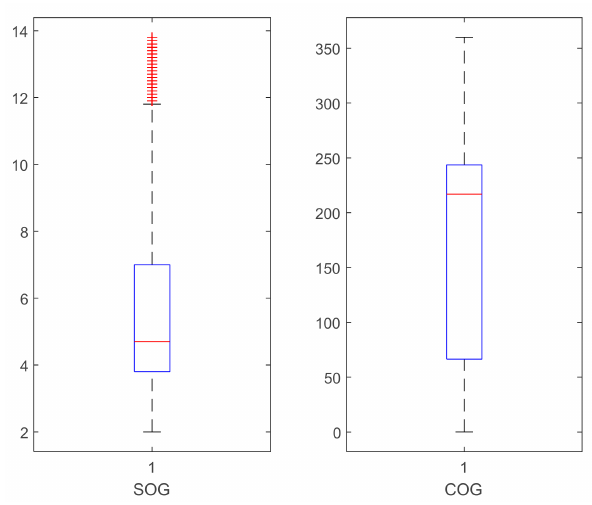
Figure 4. SOG and COG